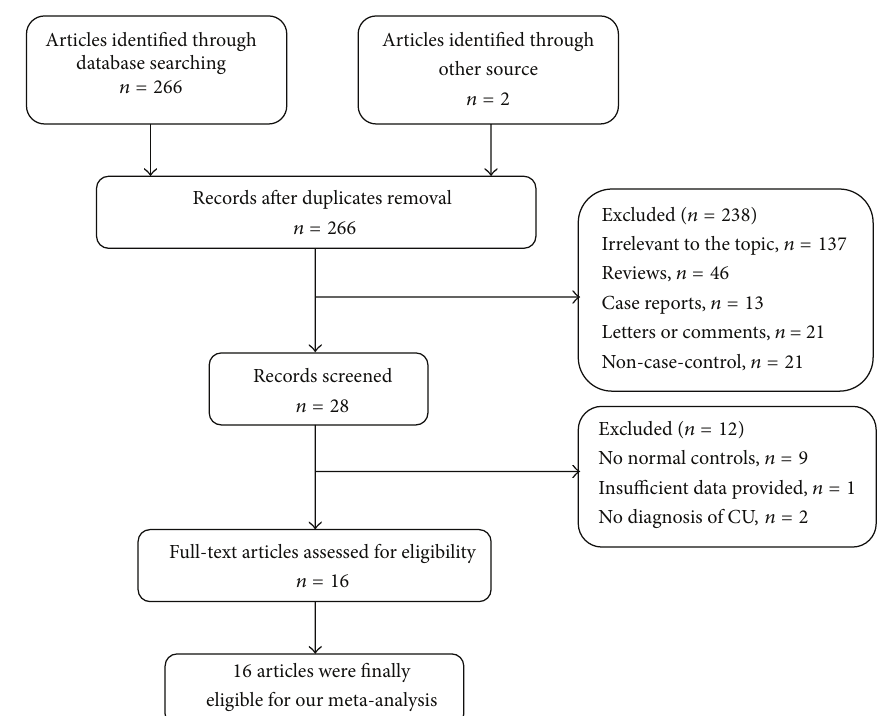
Figure 1: The flow diagram of the literature searches.